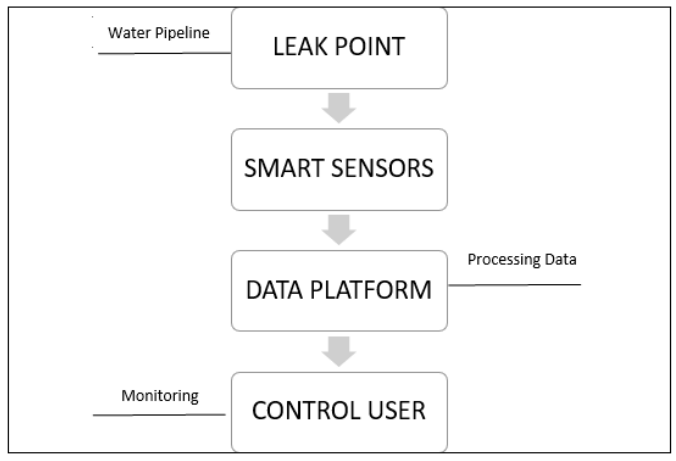
Figure 11. The development of water leak detection techniques using Internet of Things (IoT) technology and smart building sensors